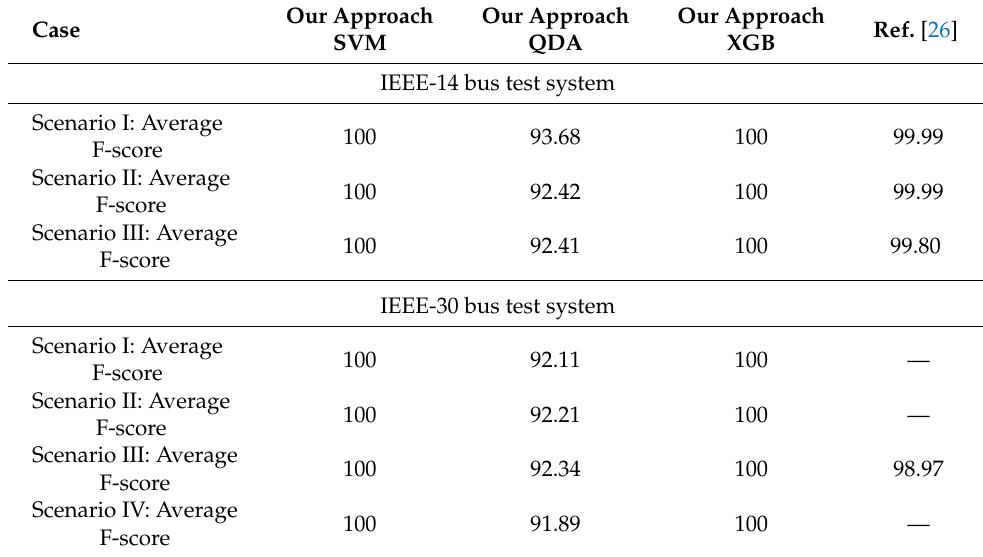
Table 9. Comparison of performance with the